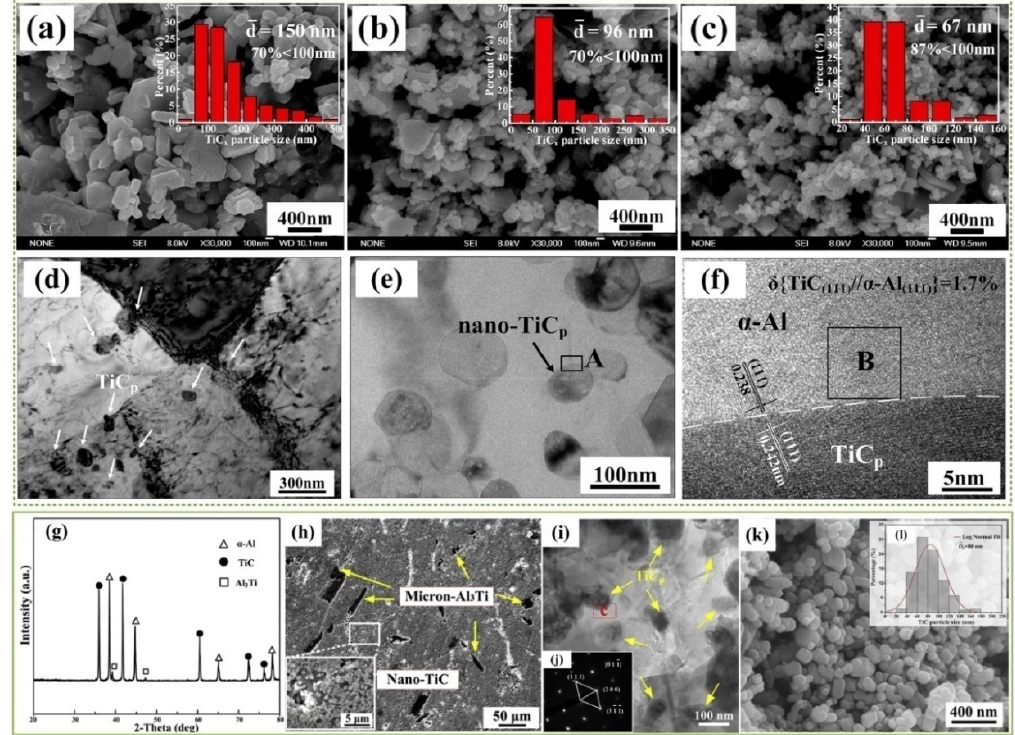
Figure 11. The nanosized TiC p extracted from the as-synthesized TiC p / Al-Cu-Mg-Si nanocomposites produced using different carbon sources: ( a ) carbon black, ( b ) mixed carbon source (50 wt.% carbon nanotubes (CNTs) + 50 wt.% carbon black), and ( c ) CNTs. The TEM images of the 10 vol.% TiC p / Al-Cu-Mg-Si nanocomposite (fabricated by mixed carbon source) after tensile testing at 298 K: ( d ) the distribution of TiC p , ( e ) the morphology and interface of the observed TiC p , and ( f ) the corresponding TiC p / α -Al interface bonding. With permission from Reference [92], copyright (2019) Elsevier; ( g ) The XRD phase analysis and SEM micrographs of ( h ) the Al-30 vol.% (TiC n -Al 3 Ti m ) master alloy, ( i ) the TEM image of nano-TiC particles in the master alloy, ( j ) nano-TiC particle selected area electron diffraction (SAED) pattern, ( k ) A FESEM micrograph of the extracted TiC particles morphology and ( f ) TiC particles size distribution statistical histogram; With permission from Reference [19], copyright (2019) Elsevier.